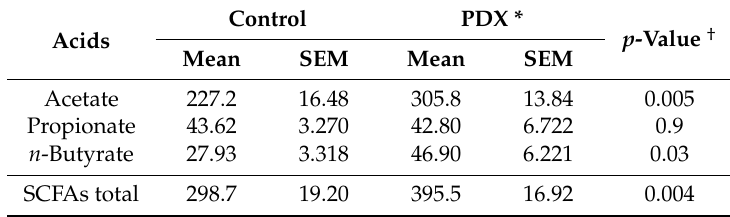
Table 1. Short-chain fatty acids (SCFAs) concentration in cecal digesta, 4 weeks after feeding (mmol/kg digesta). Control PDX * p -value † Acids Mean SEM Mean SEM Acetate 23.3 Propionate